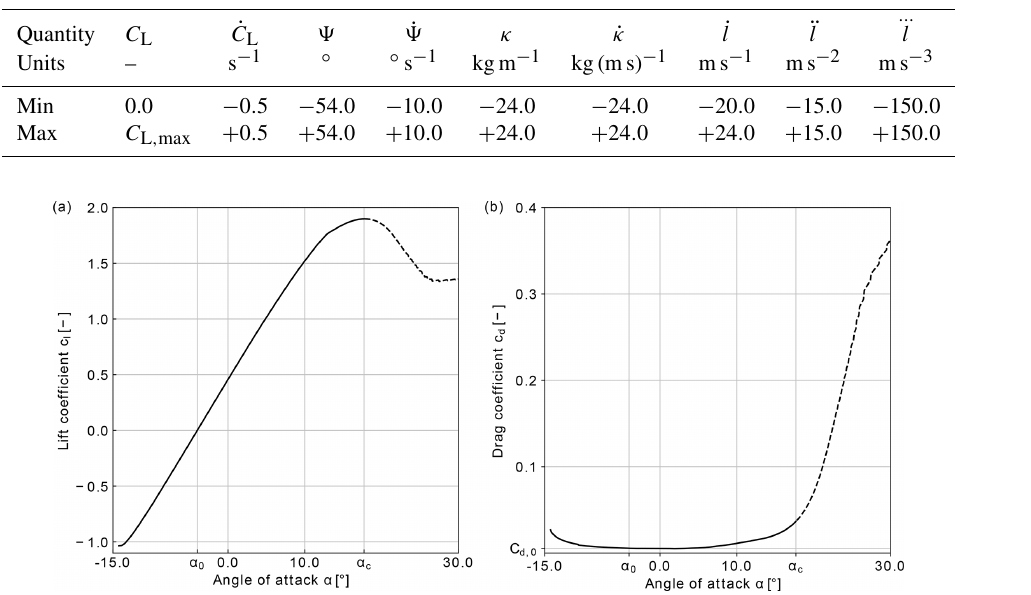
Table 3. Relaxed variable bounds used in non-linear model predictive control (Eq. 36). The maximal value of the lift coefficient is C L , max ≈ 1 . 37.